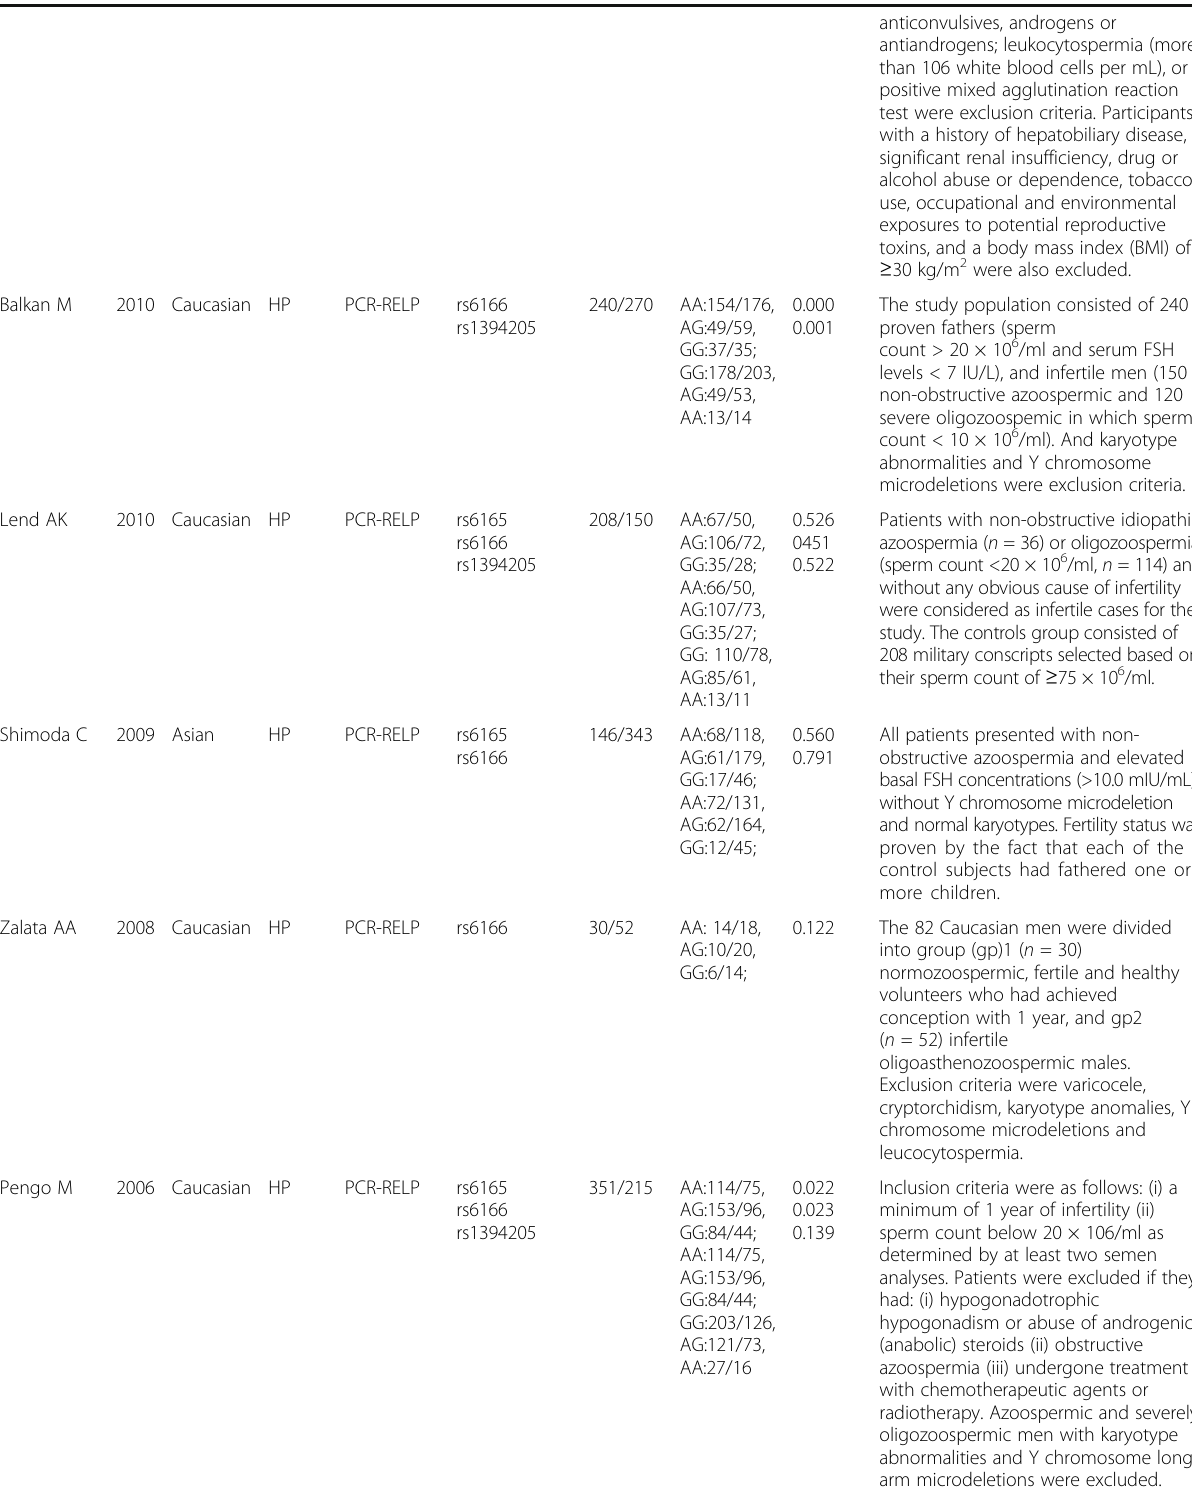
Table 4 Main characteristics of all studies on the genotype of FSHR rs6165, rs6166 and rs1394205 included in the meta-analysis (Continued)